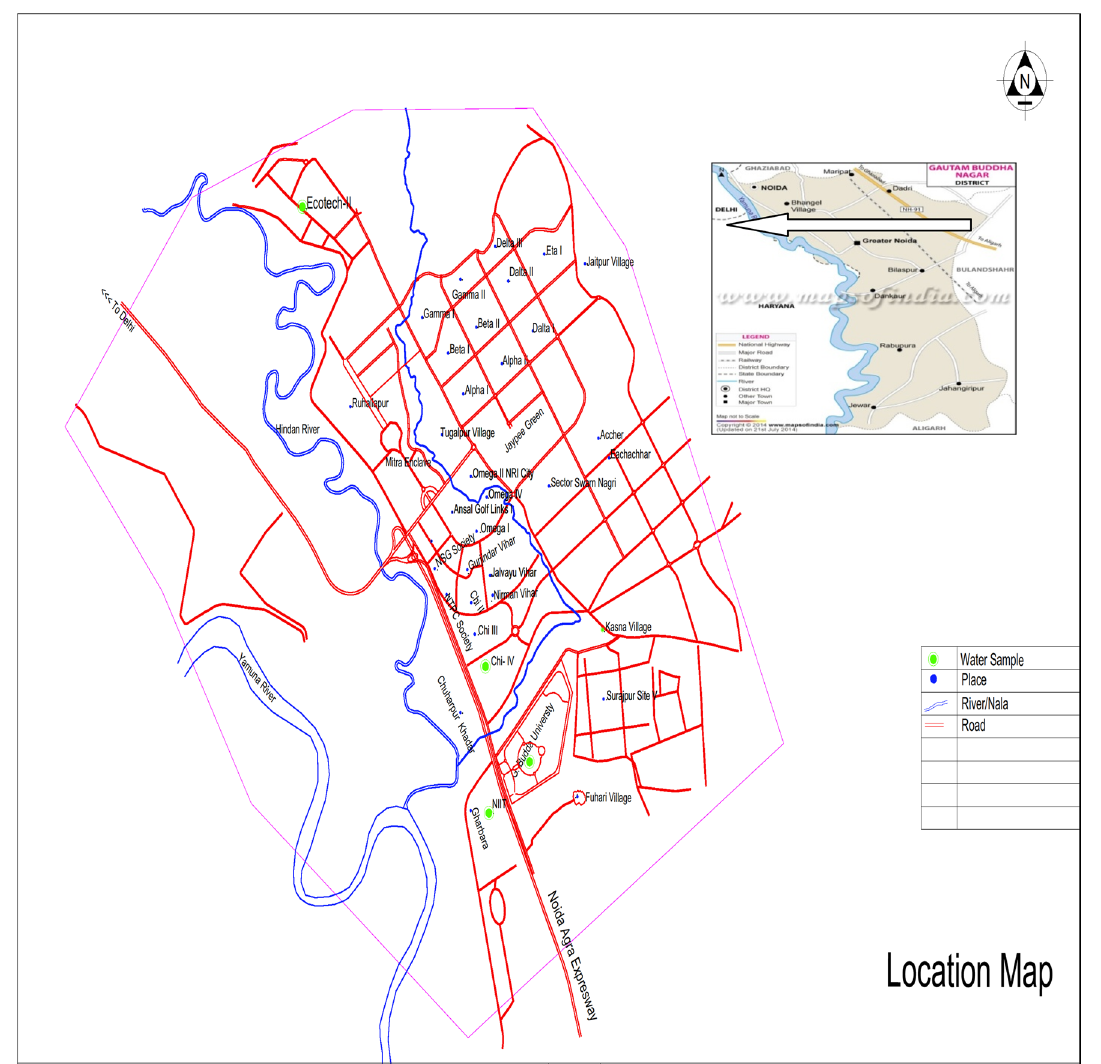
Fig. 1 Greater Noida map with locations of sampling sites of the study area. Source :